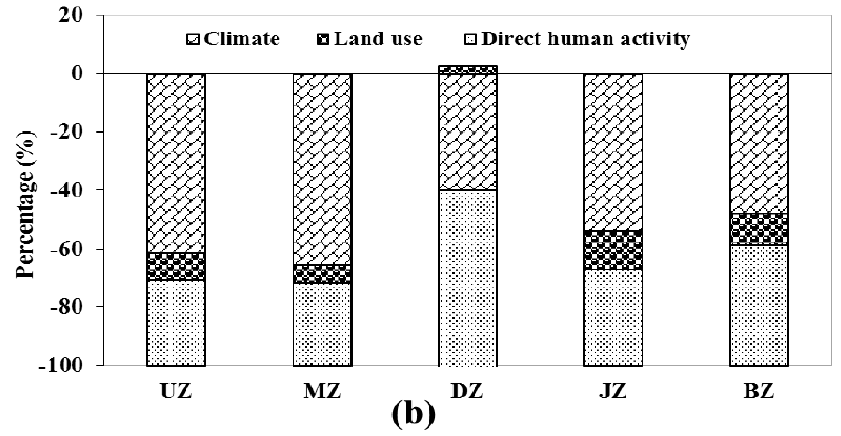
Figure 6. Proportional impact of the three factors influencing runoff during: ( a ) the 1990s; and ( b ) the 2000s.